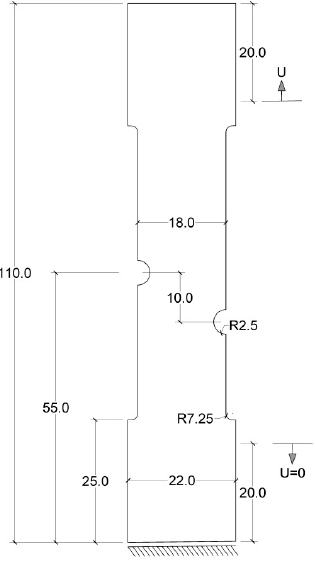
Figure 11. Sample geometry and boundary conditions. Table 4. Model parameters for the Al–5005 asymmetric notched sample.